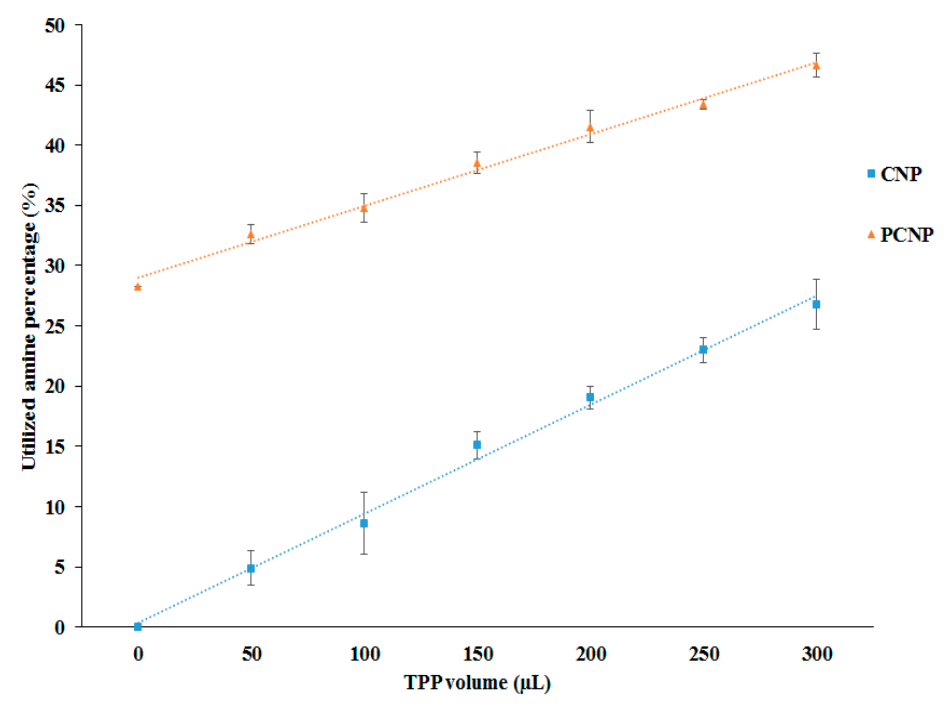
Figure 3. The utilization of amine percentage with different TPP volumes. The utilization of free amine percentage increased with increased TPP volume for CNP and pCNP. Data presented as mean ± SEM from three independent experiment replicates. Two tailed paired t -test was performed with p -value < 0.0001.